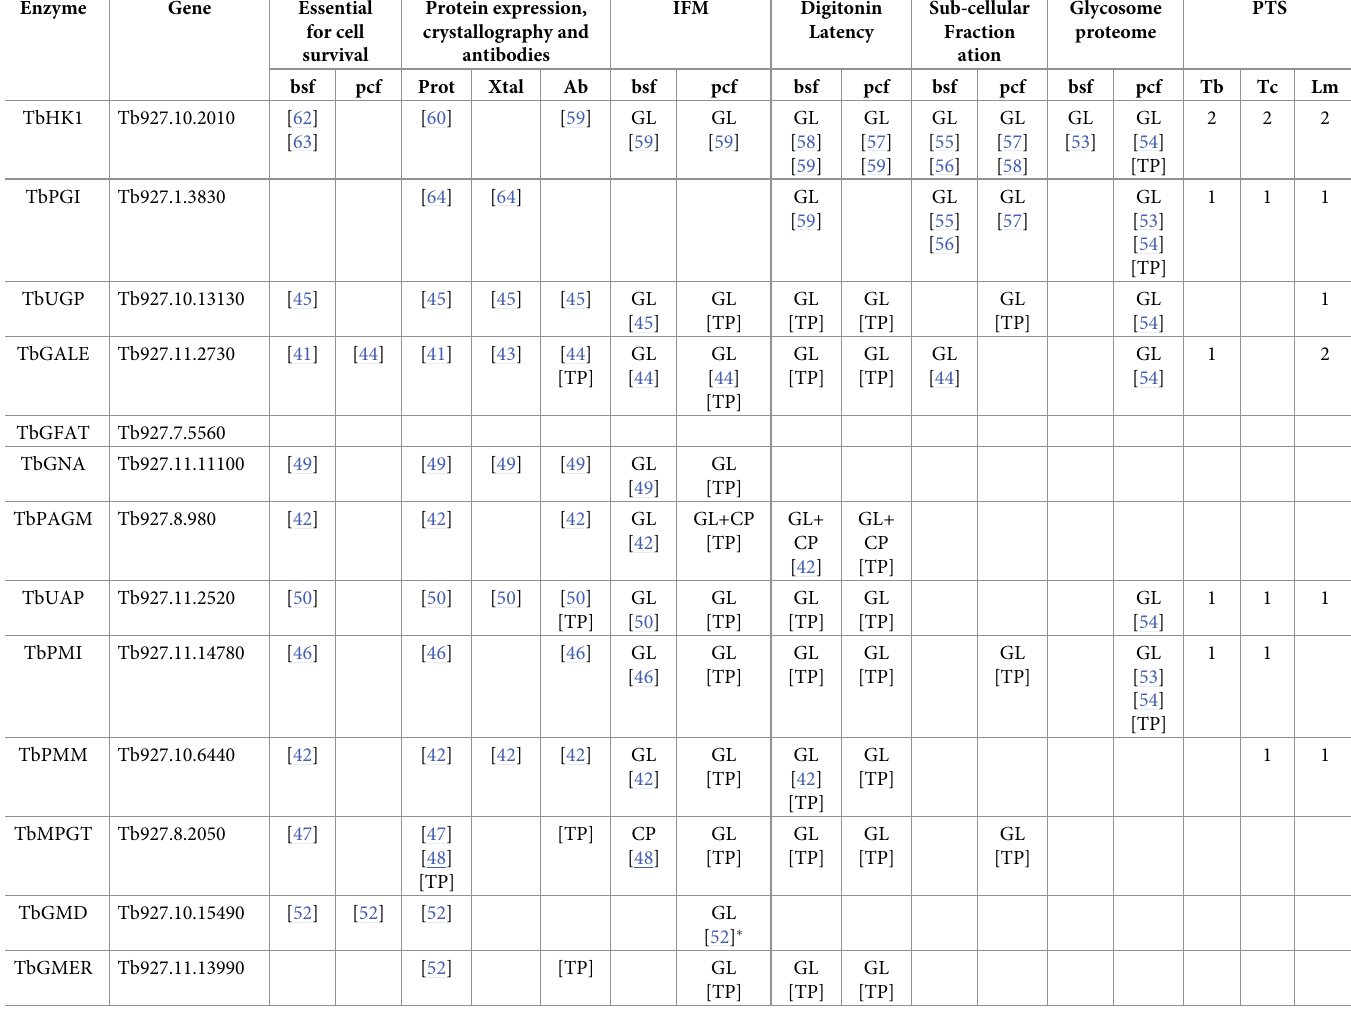
Table 1. Summary of data on T . brucei nucleotide sugar biosynthetic enzymes. Data are from the literature [#] or from this paper [TP]. GL = glycosomal; CP = cytoplasmic; IFM = immunofluorescence microscopy; � indicates that IFM was performed using an epitope tag rather than an antibody to the whole protein; PTS = peroxisome targeting sequence (type 1 or type 2) for the respective T . brucei (Tb), T . cruzi (Tc) and L . major (Lm) enzymes [50,65].Enzyme abbreviations are listed in the Introduction, with the exception of TbGFAT, glutamine: fructose-6-phosphate aminotransferase. Enzyme